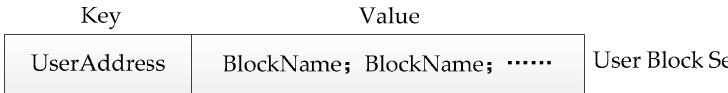
Figure 9. The B+-tree index structure of “User Block Set”. 4.2. Initialization of Redis Cache Storage 1.